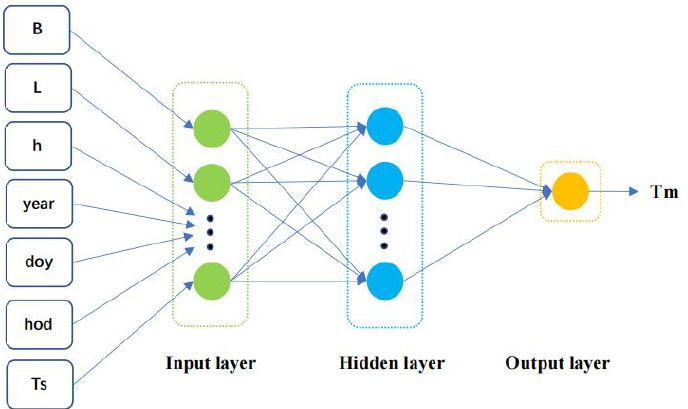
Figure 6. The structure of BPNN model.